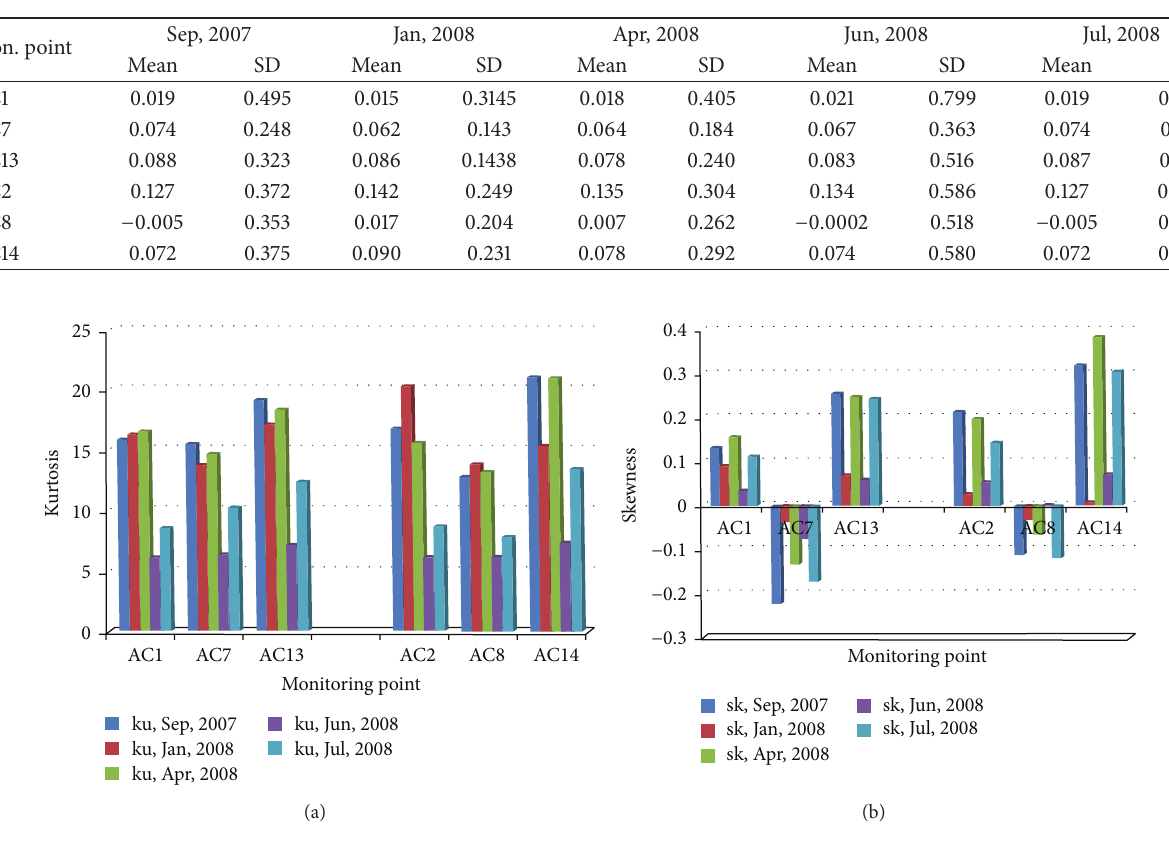
Figure 4: Monitoring acceleration (a) kurtosis and (b) skewness for selection